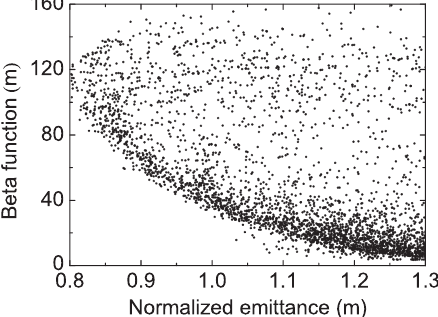
FIG. 4. Twiss functions for initial, over focusing, focusing and less focusing cases. Here over focusing is corresponding to low- energy beam focusing with quadrupole set for high-energy beam.